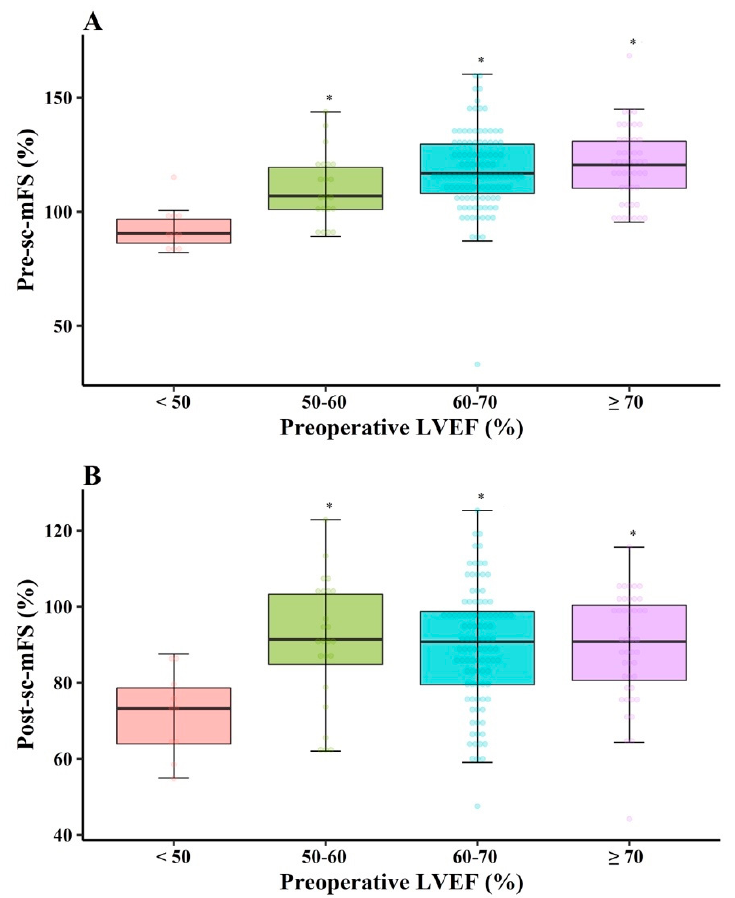
Figure 4. Preoperative ( A ) and immediate postoperative ( B ) sc-mFS after mitral valve repair for chronic primary mitral regurgitation. sc-mFS: stress-corrected midwall fractional shortening; LVEF: left ventricular ejection fraction. * p < 0.00833 versus pre-LVEF < 50%.